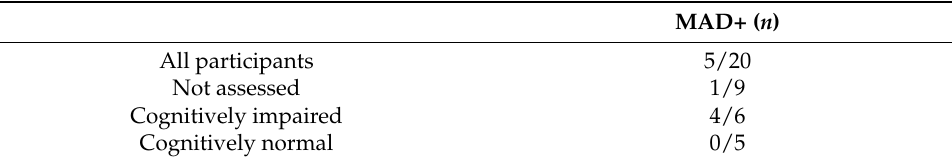
Table 2. Positive machine learning-based Alzheimer’s disease designation (MAD+, i.e., Alzheimer’s disease-like) designations. Results are broken down by neuropsychological assessment, including patients who did not receive an assessment, patients who were assessed to have cognitive deficits, and patients who were assessed as cognitively normal. MAD+ ( n ) All participants 5/20 Not assessed 1/9 Cognitively impaired 4/6 Cognitively normal